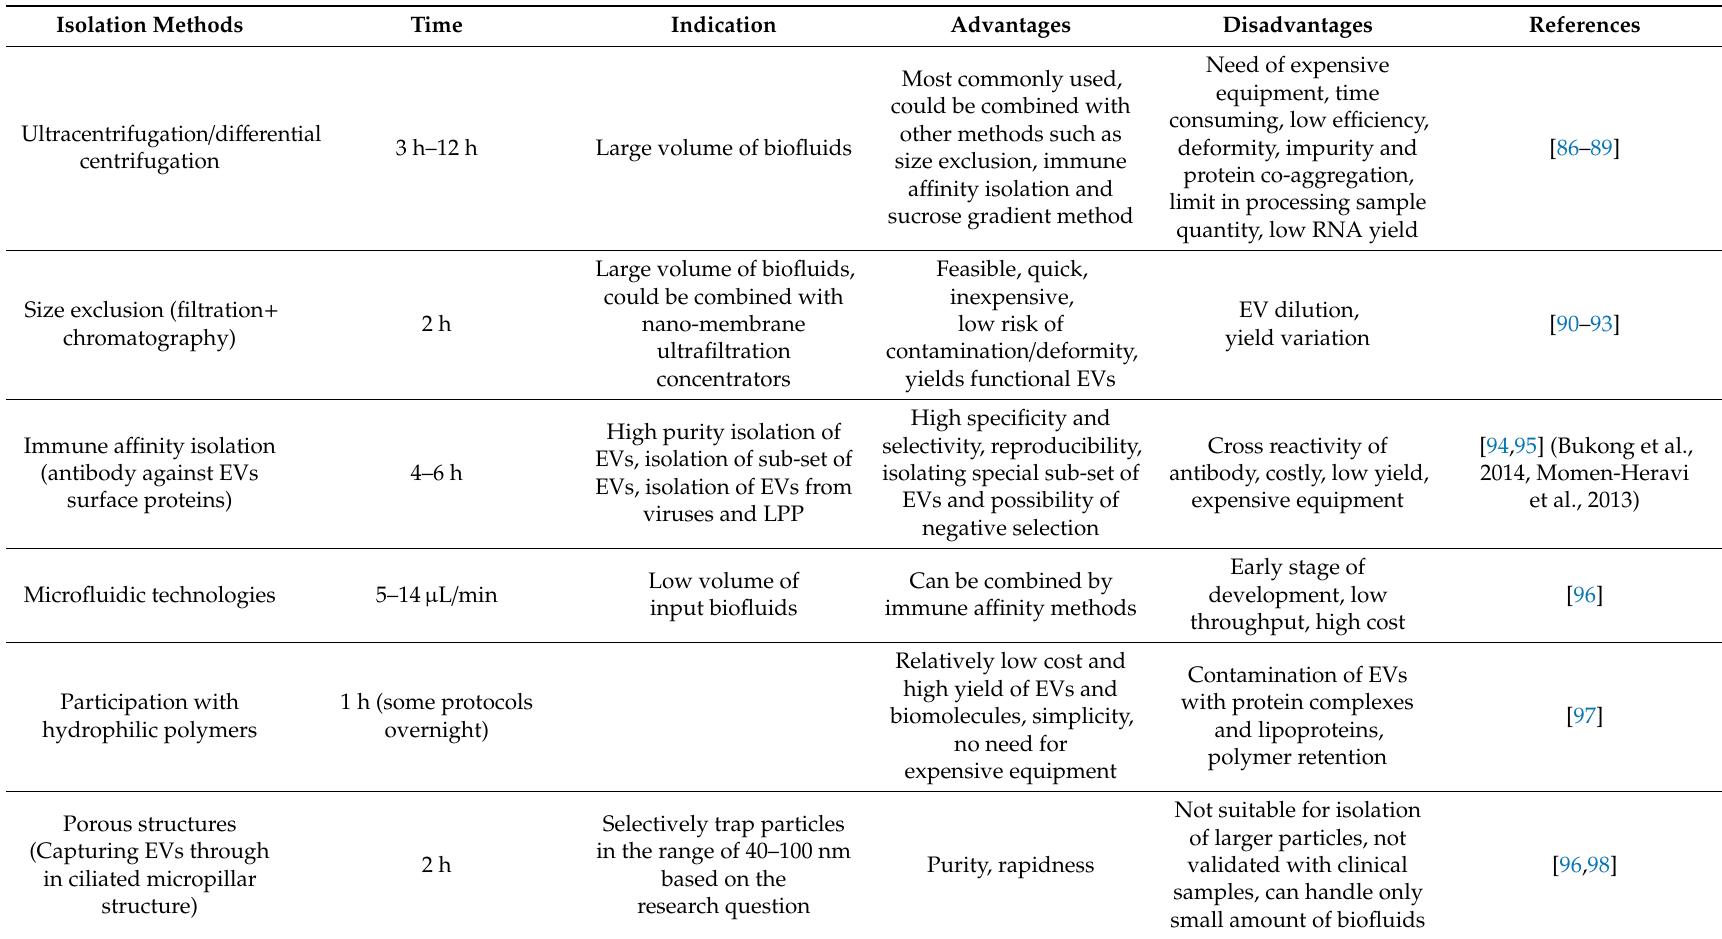
Table 1. Methods for isolation of